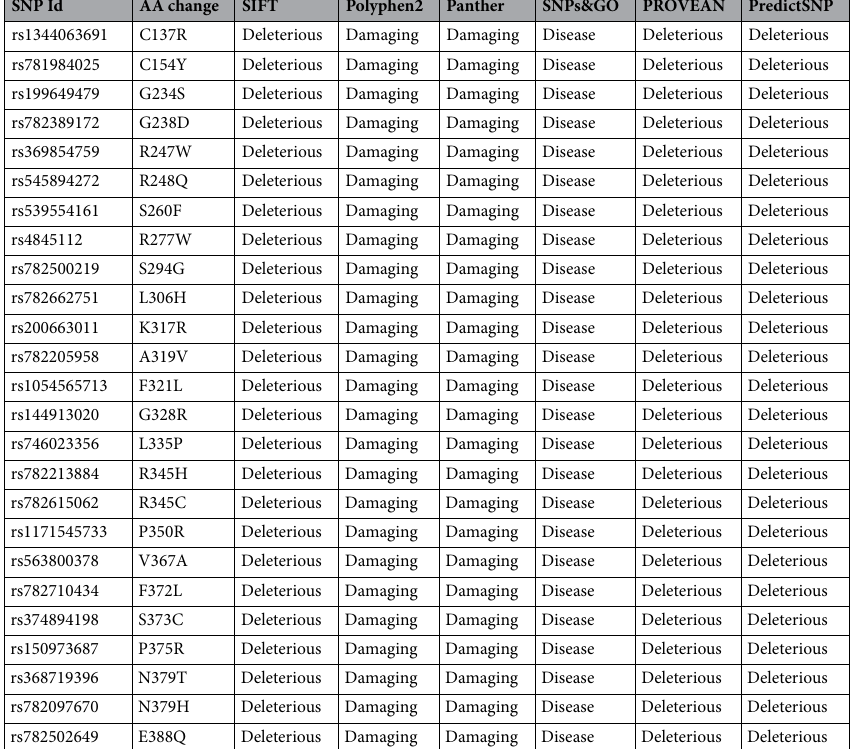
Table 1. High risk nsSNPs identified by six in silico